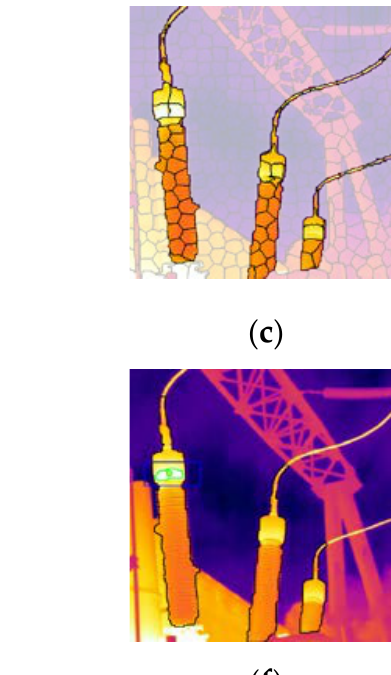
Figure 11. The results of each step in the process of diagnosis by Kim’ method ( a ) Super pixel segmentation ( b ) Image recognition ( c ) Super pixel binning ( d ) Image segmentation ( e ) Area to be inspected ( f ) Diagnosis result.